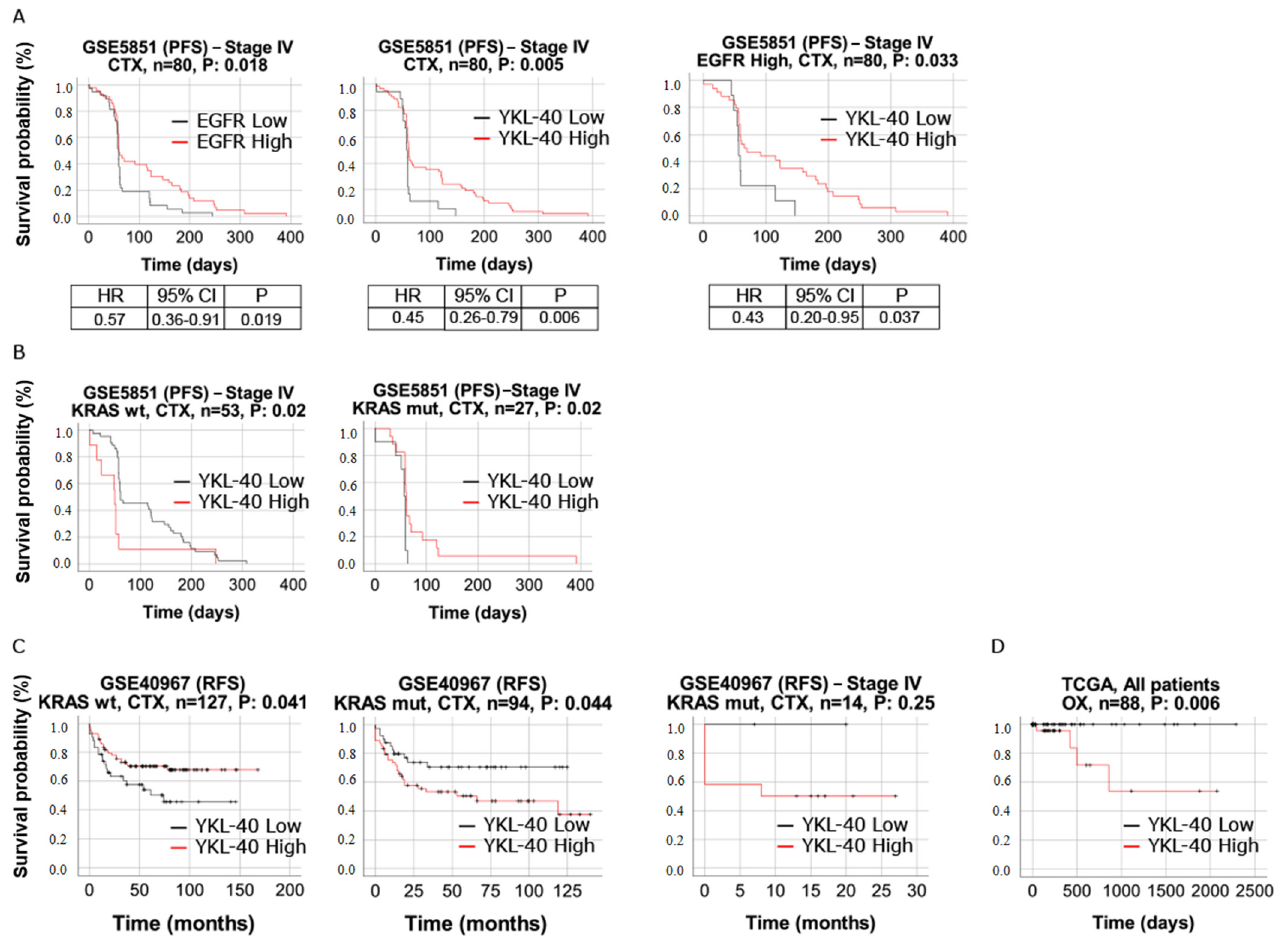
Figure 7. ( A ) Kaplan–Meier survival curves of YKL-40 high (solid line) versus YKL-40 low (dashed line) and EGFR high (solid line) versus EGFR low (dashed line) patients of cohort 5 (GSE5851). Survival curves of YKL-40 high (solid line) versus YKL-40 low (dashed line) patients belonging to the EGFR high group. ( B ) Survival curves of YKL-40 for patients of cohort 5 with WT-KRAS and mutant KRAS. ( C ) Survival curves of YKL-40 for patients of cohort 4 (GSE40967) with WT-KRAS and mutant KRAS. ( D ) Survival curves of YKL-40 high (solid line) versus YKL-40 low (dashed line) patients of cohort 6 (TCGA-COAD). For all survival curves, p -values were calculated using log-rank tests, and expression value thresholds for determining high and low groups were determined through maxstat R package. Abbreviations, CTX, cetuximab; OX, oxaliplatin.